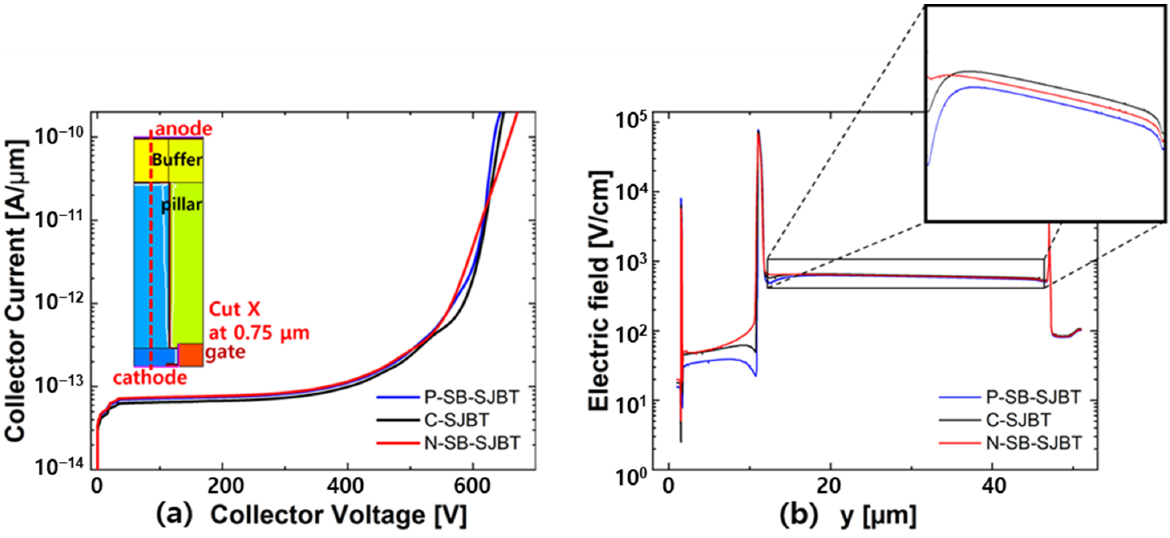
Figure 6. ( a ) The breakdown voltage characteristic and ( b ) electric field distribution in the p-pillar (x = 0.75